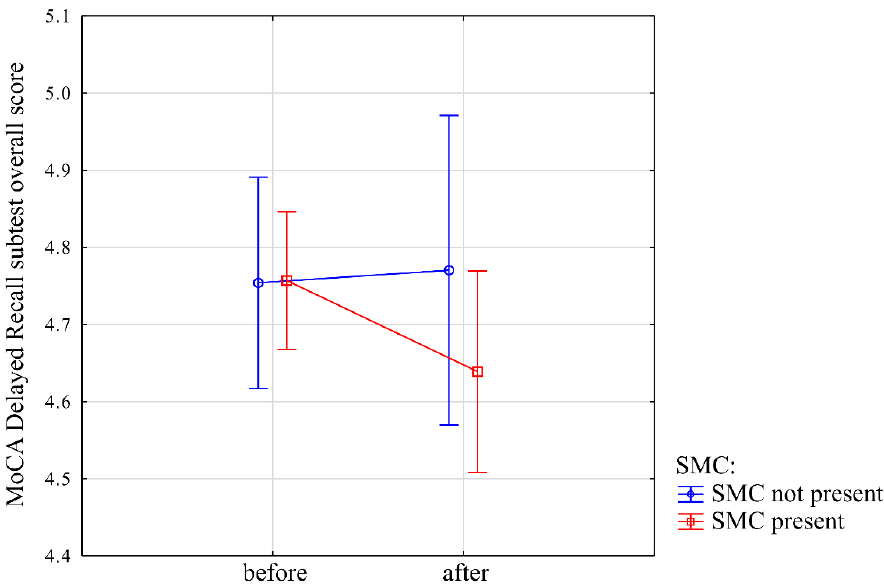
Figure 3. Interaction between time and subjective memory complaint (SMC) presence and results of the overall MoCA Delayed Recall subtest. Y-axis represents the number of words overall recalled correctly in the short-term verbal memory test in MoCA, after category, and the list cues. First, a category of word was recalled, then the participant was asked to choose the correct word from a list of three words from the same category. Sum of the overall number of words recalled by the participant themselves, with the category and list cue. X-axis (“before” and “after”) denotes the initial time- point and after two years, respectively. Blue line indicates a subgroup without subjective memory complaints, while the red line indicates scores of participants with subjective memory complaint.